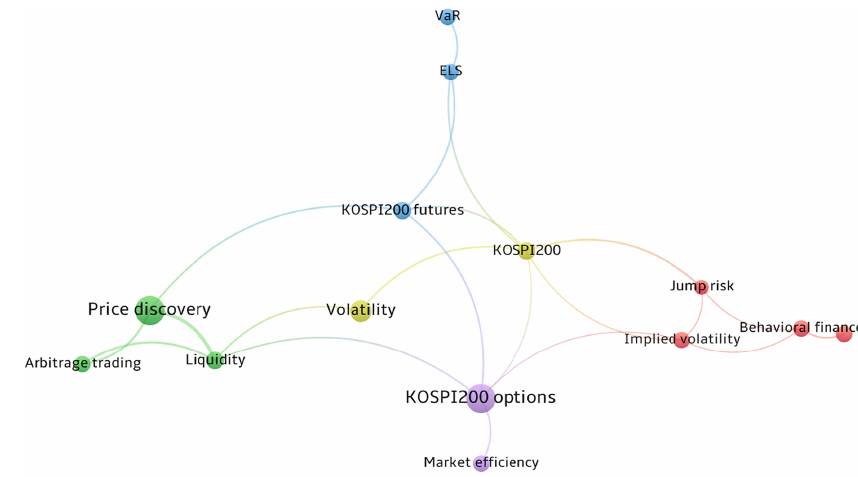
Figure 1. Keyword-levelnetwork